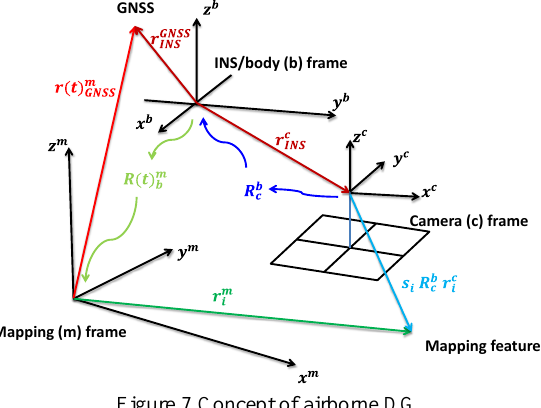
Figure 7 Concept of airborne DG